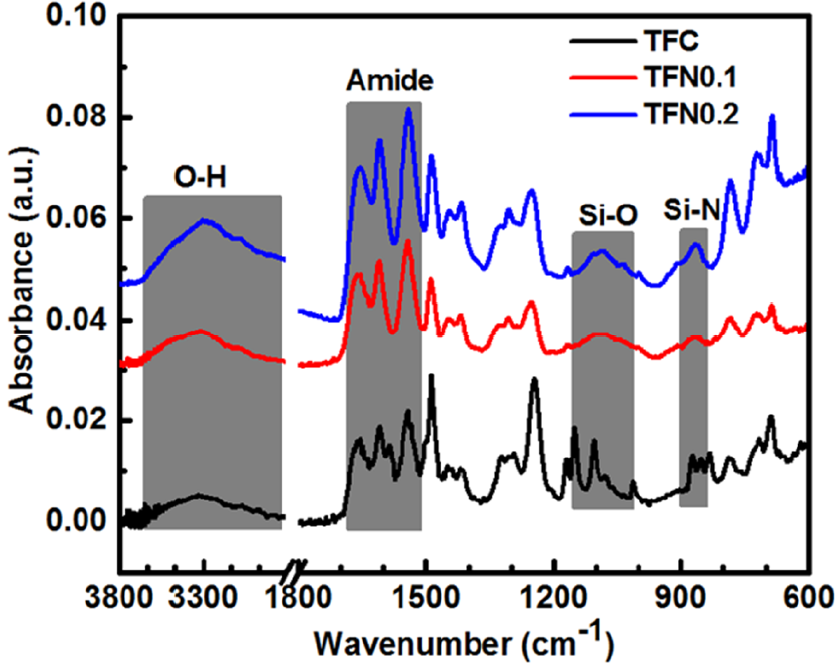
Figure 6. ATR-FTIR spectra of the membranes with different PTS loads.